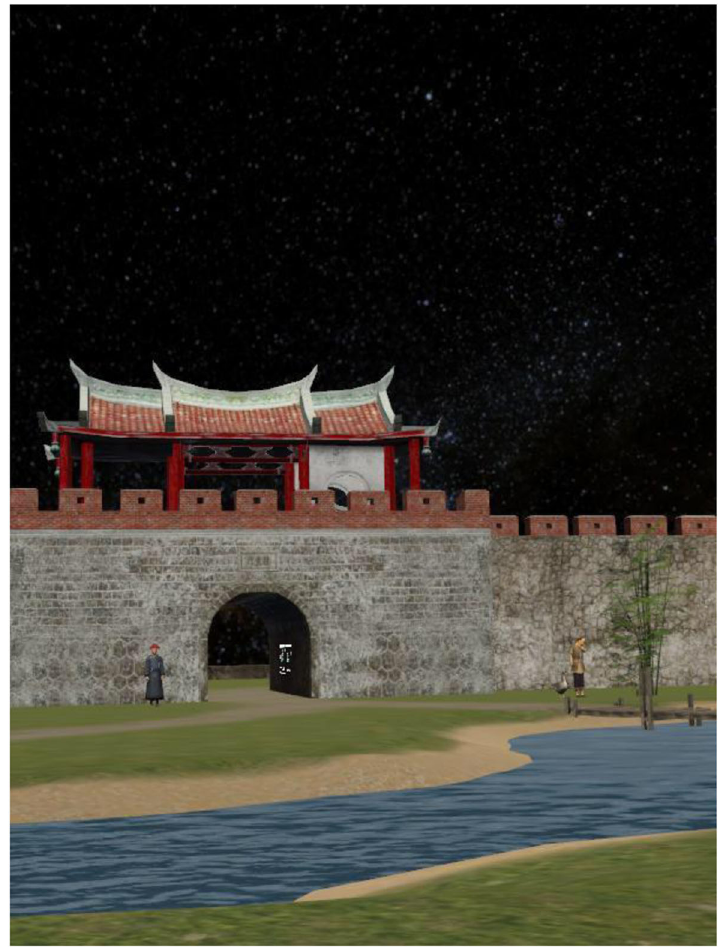
Fig. 3 Screenshot of the Our Old City VR